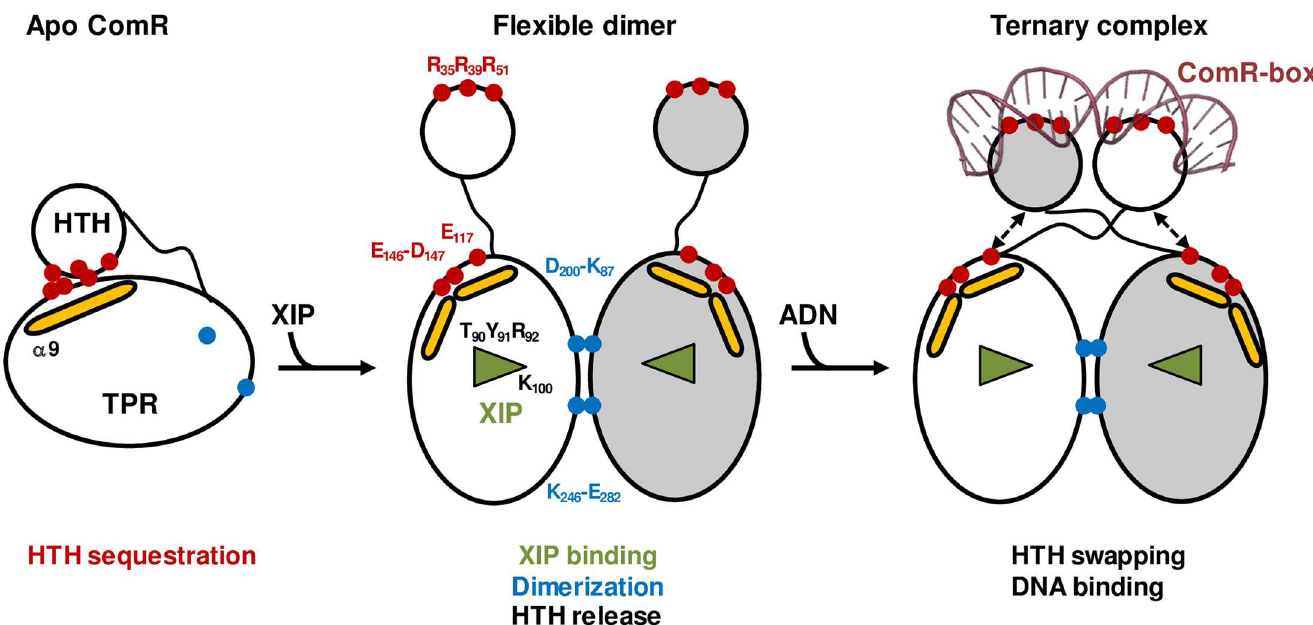
Fig 9. Mechanism of ComR activation by the XIP peptide. The empty XIP-binding pocket of the apo form of ComR is represented by an open triangle. Helix α 9, which undergoes a major conformational change,is shown as a yellow stick. Key ComR residues are labeled,in black for XIP bindingand activationresidues (T90, Y91, R92, and K100), in red for residuesinvolvedin DNA bindingand HTH sequestration (R35, R39, R51, E117, D146, and E147) and in blue for residuesof the dimerization interface (K87, D200, K246, and